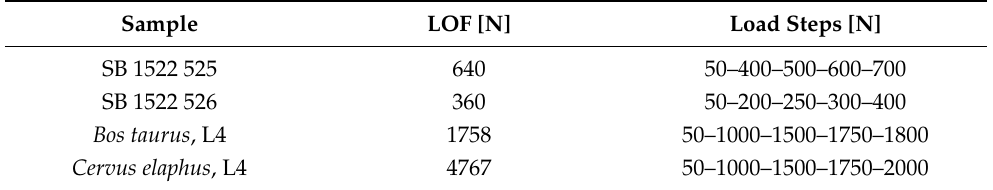
Table 3. Load of failure of one specimen each and the resulting load.